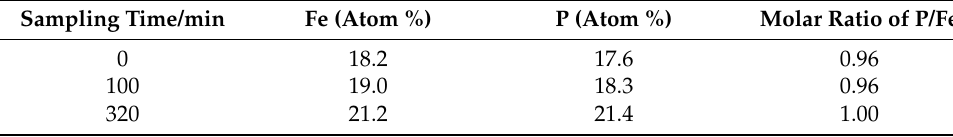
Figure 9. The mass fraction trend of Fe in precipitation at different reaction time. Table 5. Composition of produced precipitate under different